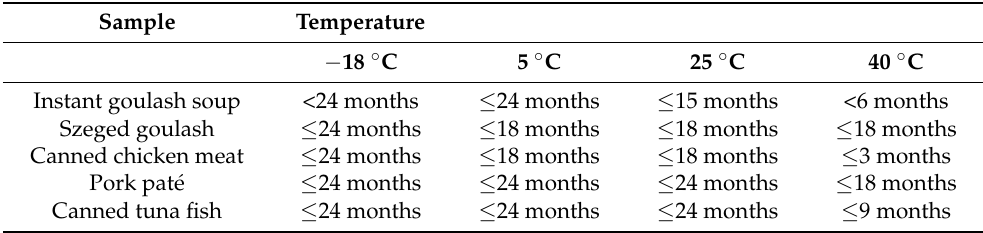
Table 5. Combination of certain storage temperatures ( − 18 ◦ C, 5 ◦ C, 25 ◦ C and 40 ◦ C) and critical time (months) for preserving food quality and safety of five foods tested (instant goulash